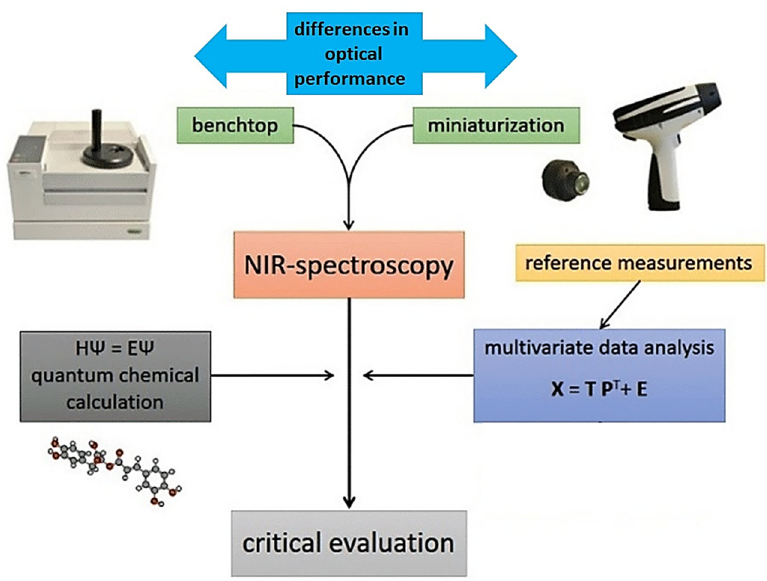
Figure 1. The workflow of the multiplanar methodology used for understanding the instrumental performance and increasing the accuracy, flexibility, and applicability of miniaturized NIR spec- troscopy.